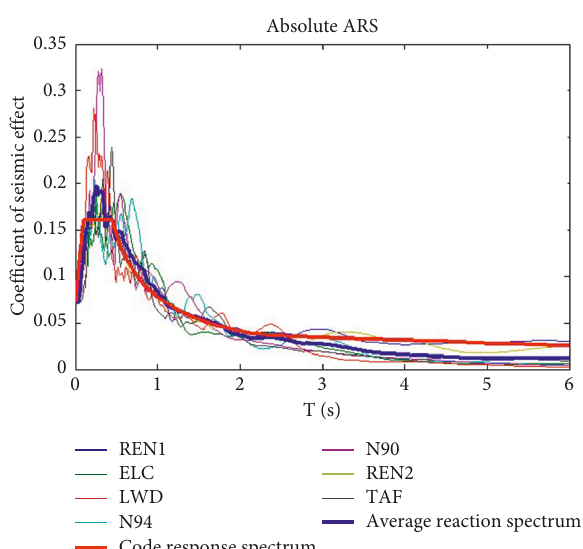
Figure 35: 7 time course response spectra with canonical response spectra